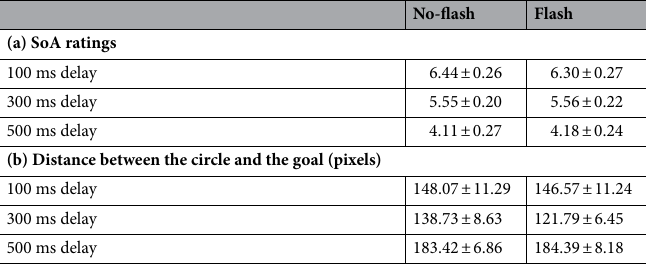
Table 3. Results in experiment 3. Mean ±